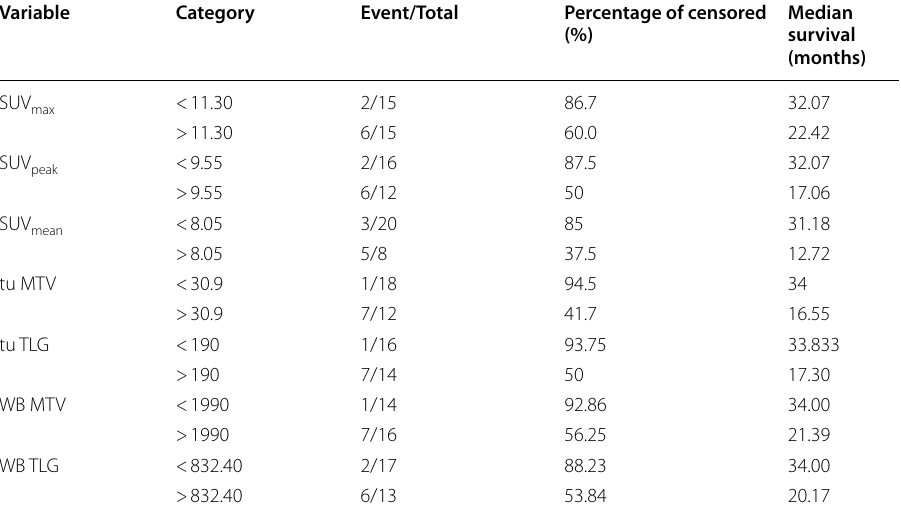
Table 3 Mean overall survival values of high and low-risk groups categorized according to different PET parameters